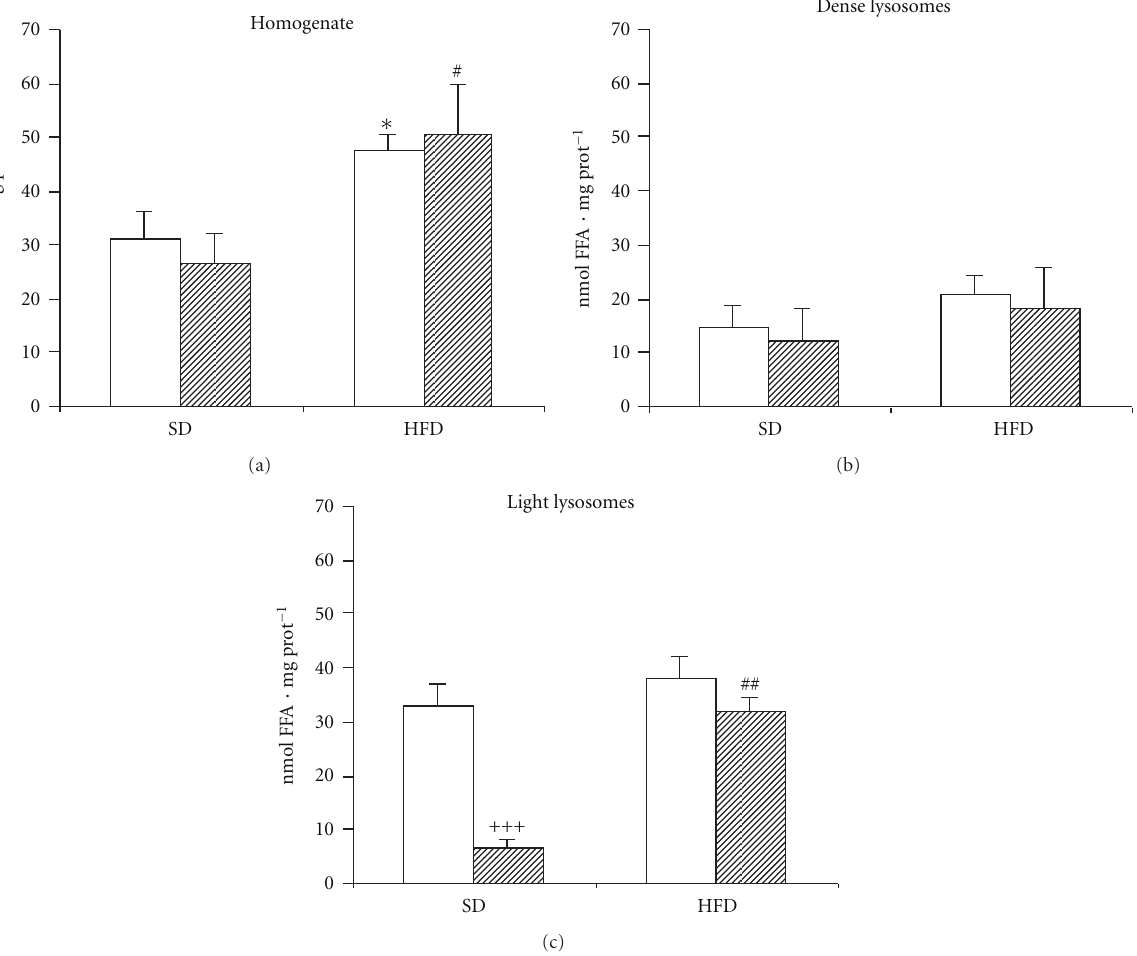
Figure 2: The e ff ect of HFD on the LIPA activity measured as FFA release from endogenous TAG. (a) Homogenate; (b) dense lysosomes; (c) light lysosomes. 10% liver homogenate, light or dense lysosomal fraction were incubated 60min at pH = 4.5. At the end of incubation, the released FFAs were quantified as described in Section 2. The graph shows the di ff erence between FFA concentration in the sample at the beginning and at the end of the incubation. Open bars = fasted animal; hatched bars = fed animals. +++ P < 0 . 001 fed versus fasted; ∗ P < 0 . 05 HFD fasted versus SD fasted; # P < 0 . 05, ## P < 0 . 01 HFD fed versus SD